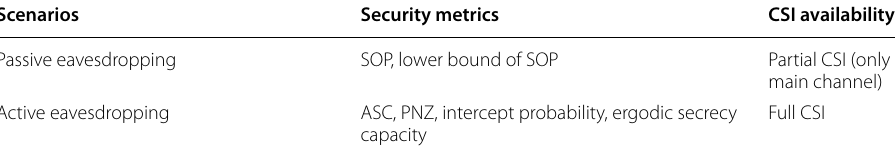
Table 1 PLS statistical performance